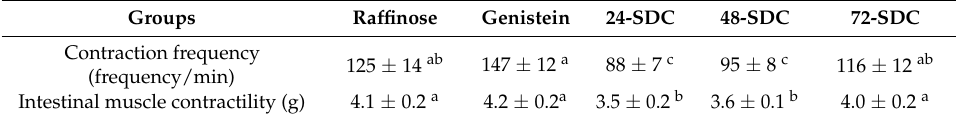
Table 4. In vitro small-intestine movement effects of raffinose, genistein, and SDC. Groups